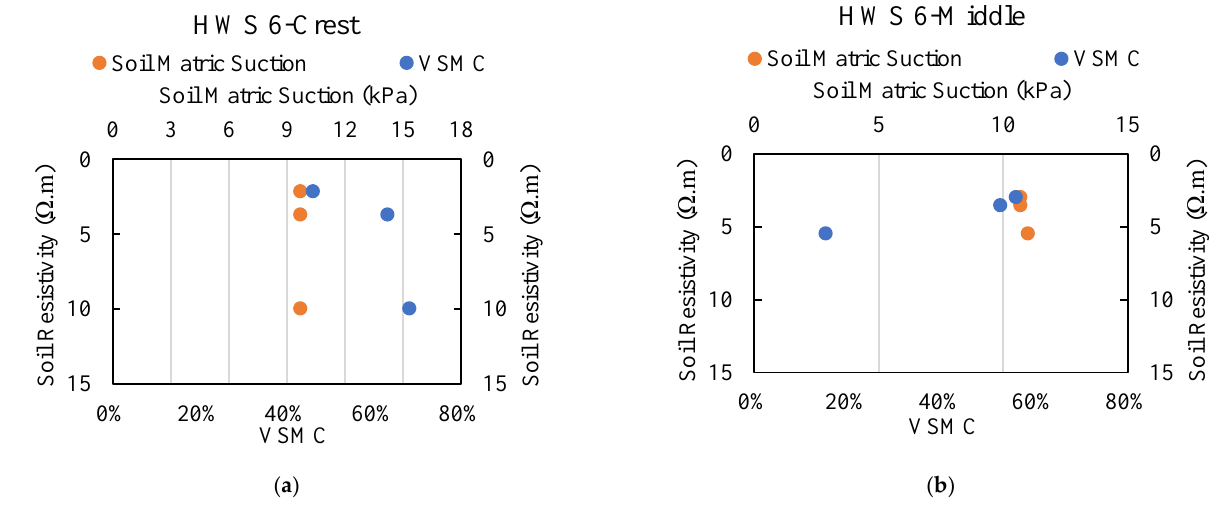
Figure 31. HWS 6 comparison of 2D ERI test profile with field instrumentation ( a ) At crest of the slope ( b ) At middle of the slope (1 m = 3.28 ft; 1 mm = 0.039 in; 1 kPa = 20.89